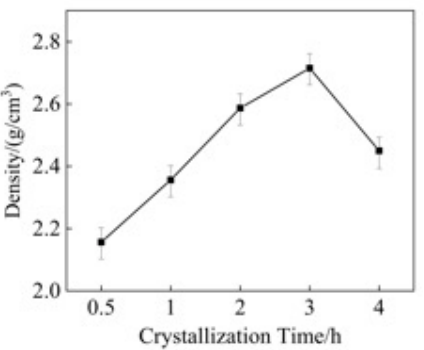
Figure 11. SEM images of microcrystalline glass samples at different crystallization times: ( a ) 0.5 h, ( b ) 1 h, ( c ) 2 h, ( d ) 3 h, and ( e ) 4 h.